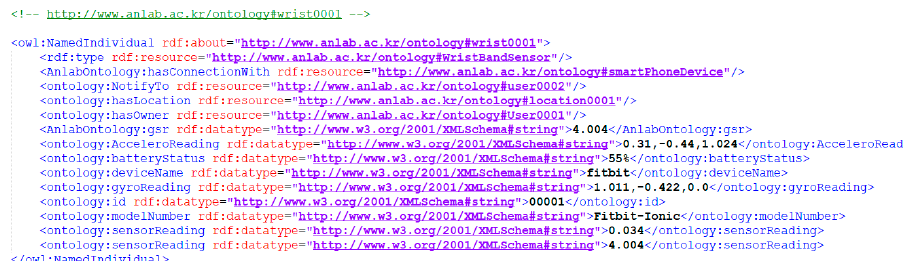
Figure 6. Semantic representation of smart phone device VO.